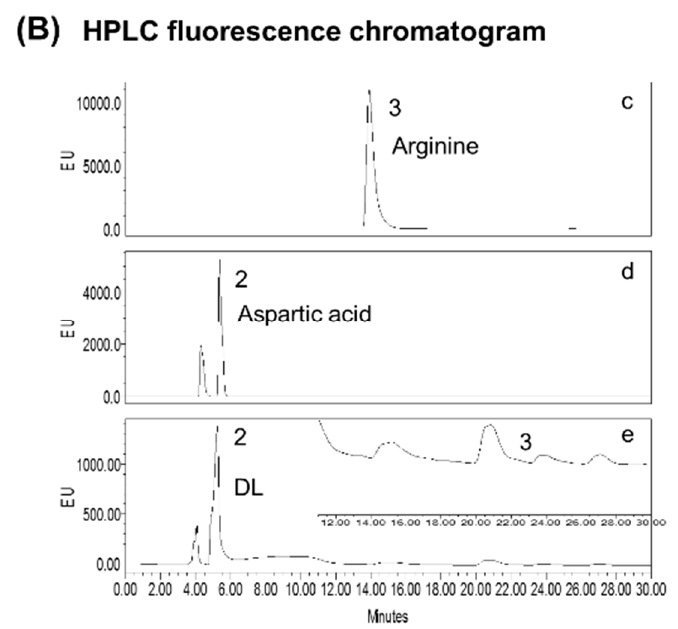
Figure 1. HPLC chromatogram for determining DL. ( A ) HPLC-UV chromatogram of trigonelline (1, a) and DL (b) at 264 nm. ( B ) HPLC fluorescence chromatogram of arginine (3, c) and aspartic acid (2, d) as standard components, and DL (e). HPLC, high-performance liquid chromatography; DL, D.